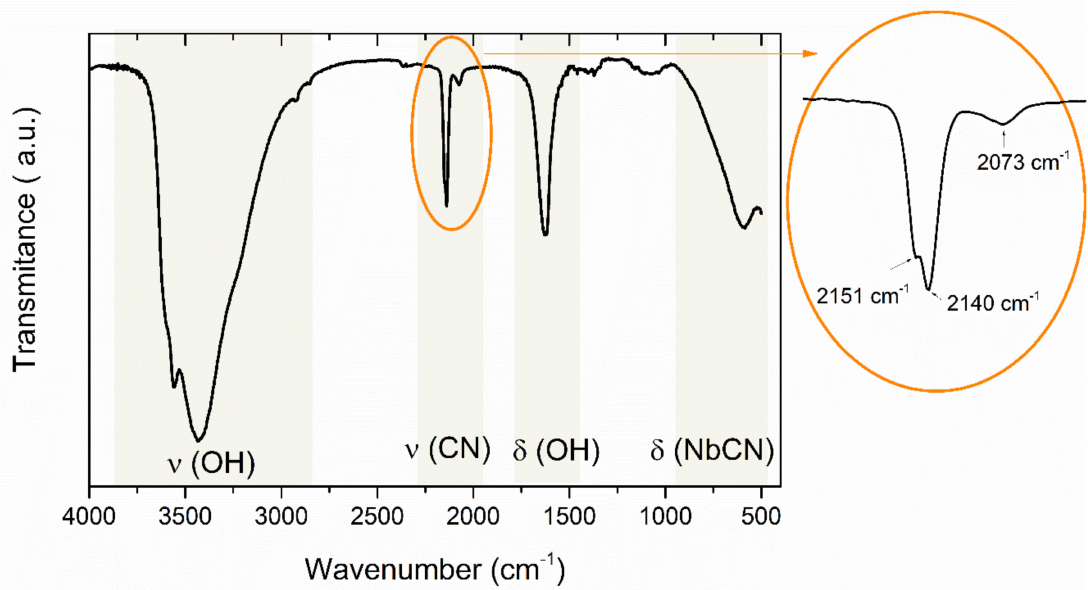
Figure 3. FT-IR spectra of [Fe II (H 2 O) 2 ] 2 [Nb IV (CN) 8 ] · 4H 2 O recorded in KBr pellets with a tentative band